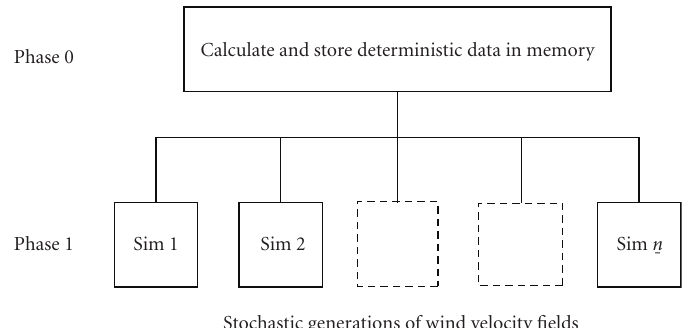
Figure 1: Adopted computational scheme for wind simulation.